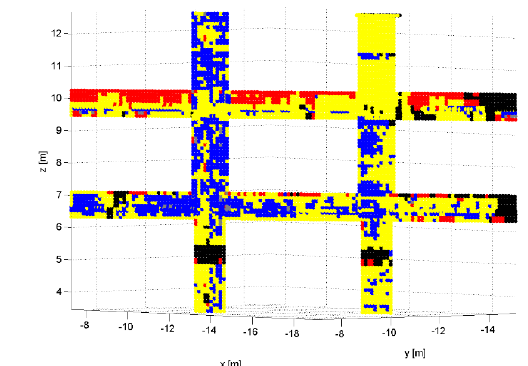
Figure 9. Results for each raster cell, “conflict”: not occupied by A but verified by B (grey), “free” (red), “unknown” (black), “occupied by A but not verified by B” (yellow), “occupied by A and verified by B”